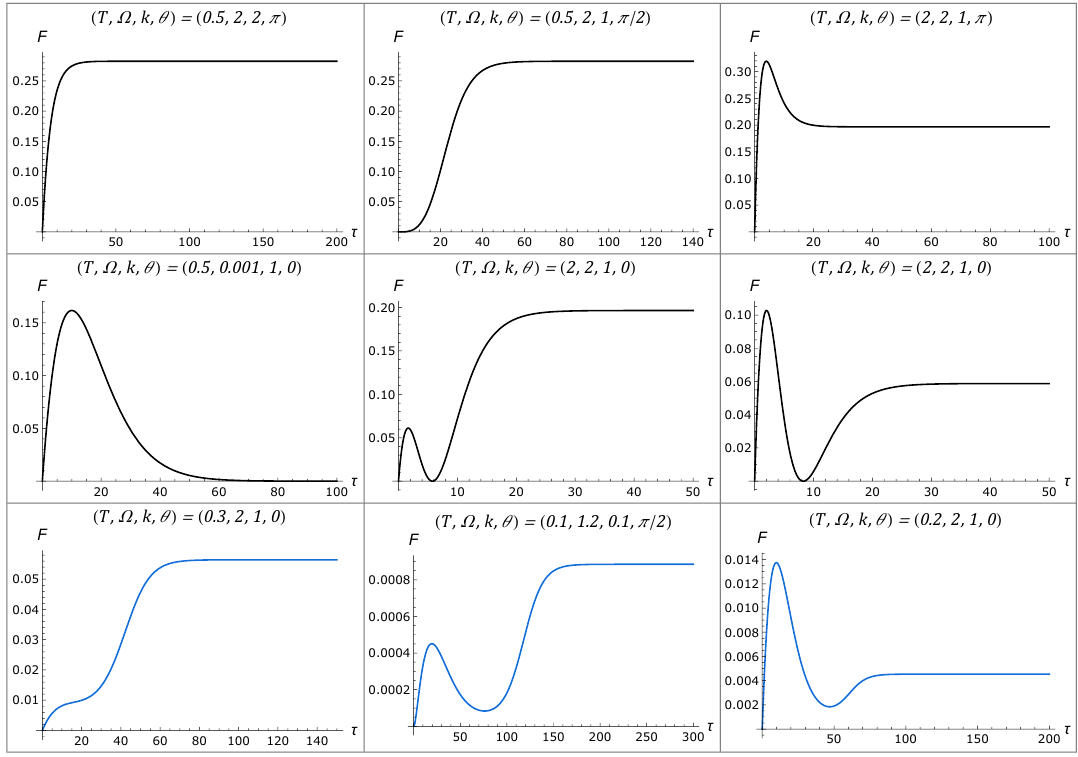
Figure 5 . A gallery of different qualitative behaviors of the time evolution of Fisher information in AdS 4 . The curves in black are under transparent boundary condition ( ζ = 0 ), and the curves in blue are under Dirichlet boundary condition ( ζ = 1 ). The first six panels (aka the ones with transparent boundary condition) are qualitatively identical to those in figure 1. We see that AdS 4 encompasses all the qualitative behaviors present in dS 4 , as well as three (bottom row) that are not present in dS 4 , under nontrivial boundary